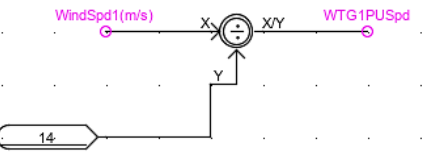
Figure 20. Control’s compiler settings for the induction generator model.